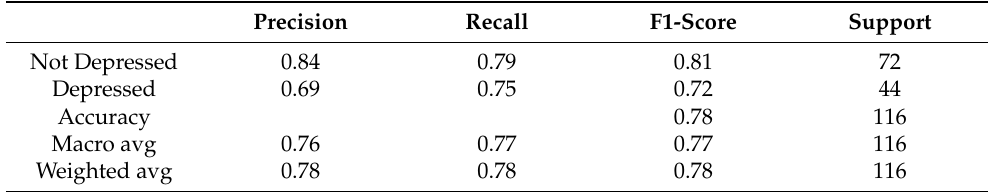
Table 4. Summary results of the precision, recall, F1-Score for each class obtained from the proposed work with unseen